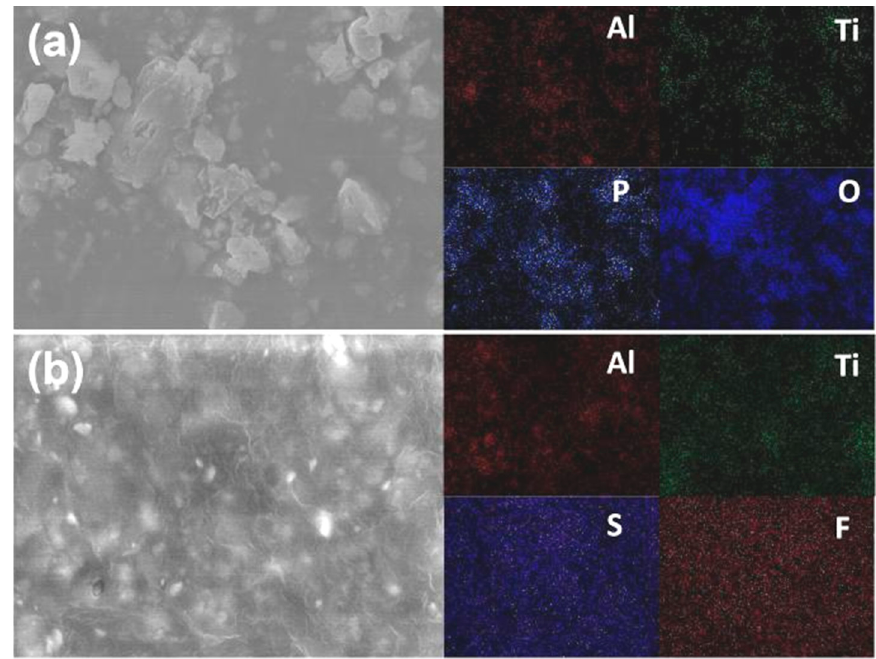
Figure 3. EDS mapping images of LATP ( a ) and 50% LATP composite electrolyte ( b ).